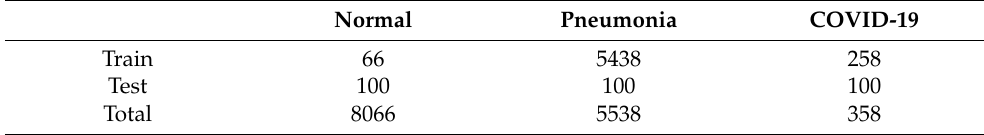
Table 1. Numbers of images per class in the COVIDX